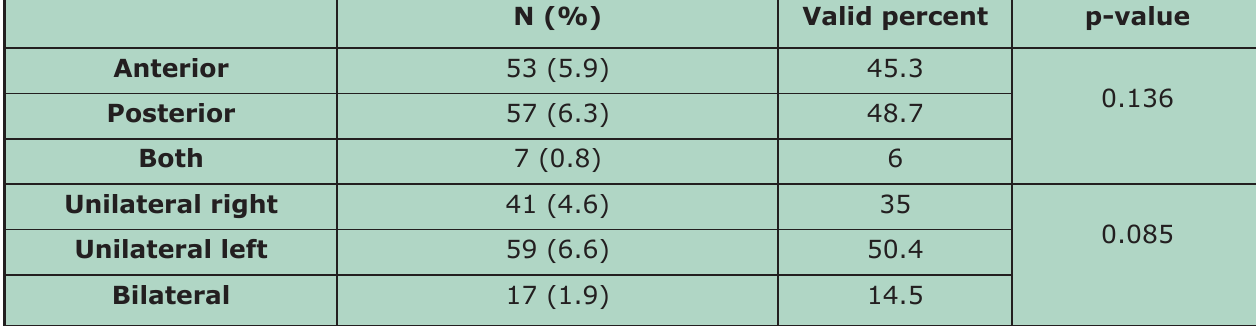
Table-IV: Prevalence of anterior and posterior crossbite.